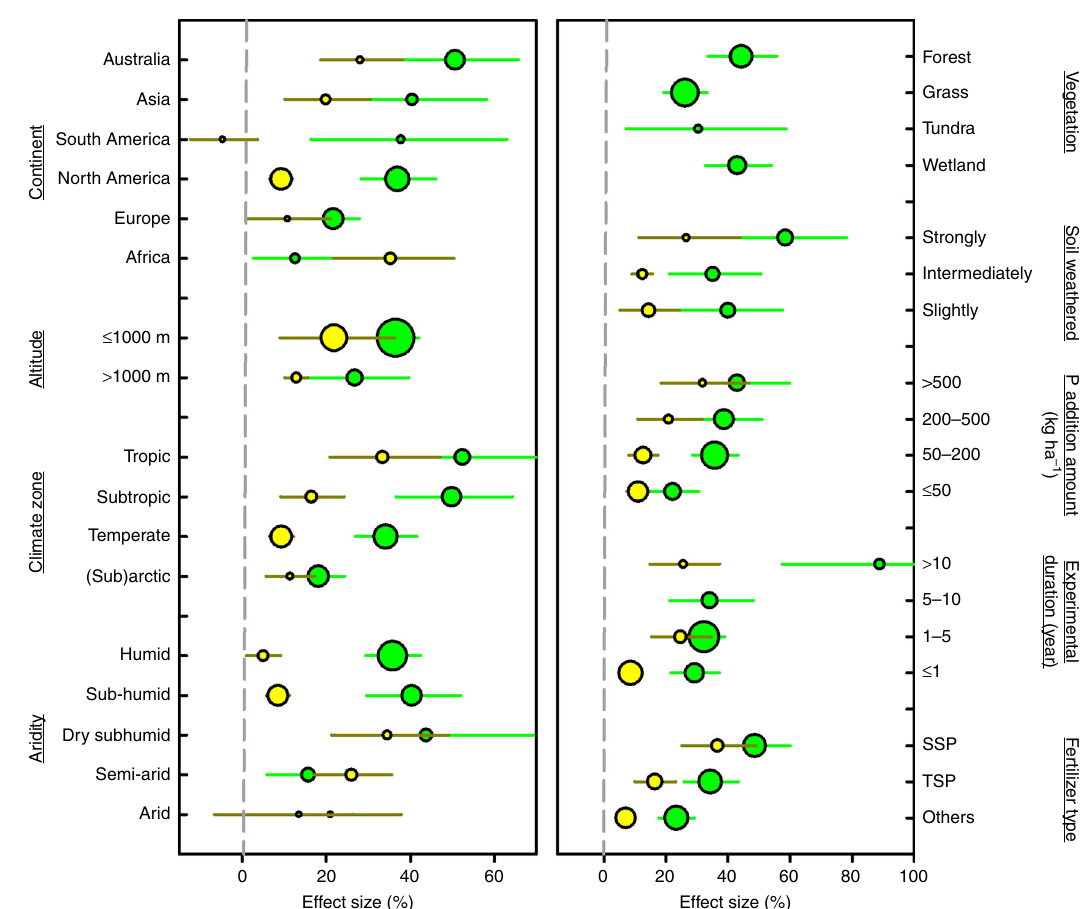
Fig. 3 P limitation was signi fi cant in all regions and major types of ecosystems and under various fertilization regimes. Exceptions are the non- signi fi cant P limitation in two groups of experiments in the croplands that had a small sample size ( N = 8). Natural terrestrial ecosystems are shown in green (total N = 436), and croplands are shown in yellow (total N = 216). Values represent effect sizes ± 95% con fi dence intervals. The size of each point is proportional to the sample size (sample sizes are listed in Supplementary Table 3). The dashed lines indicate the no-fertilization effect. SSP is single superphosphate, and TSP is triple superphosphate. Source data are provided as a Source Data fi le.